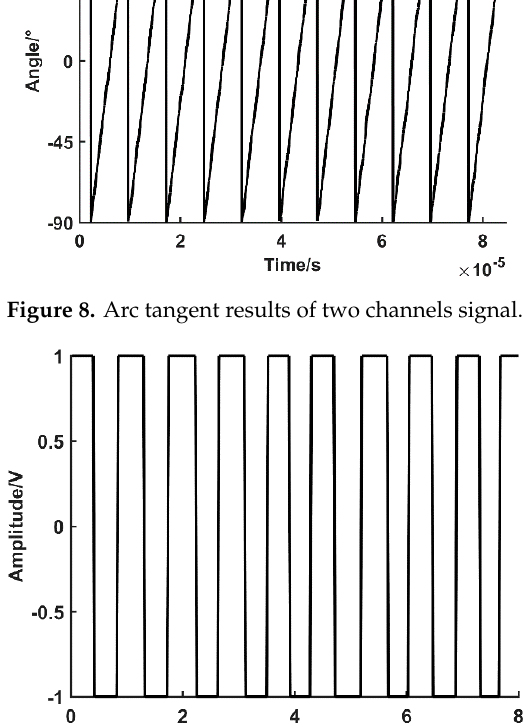
Figure 9. The transformed result of analog pulse signal.